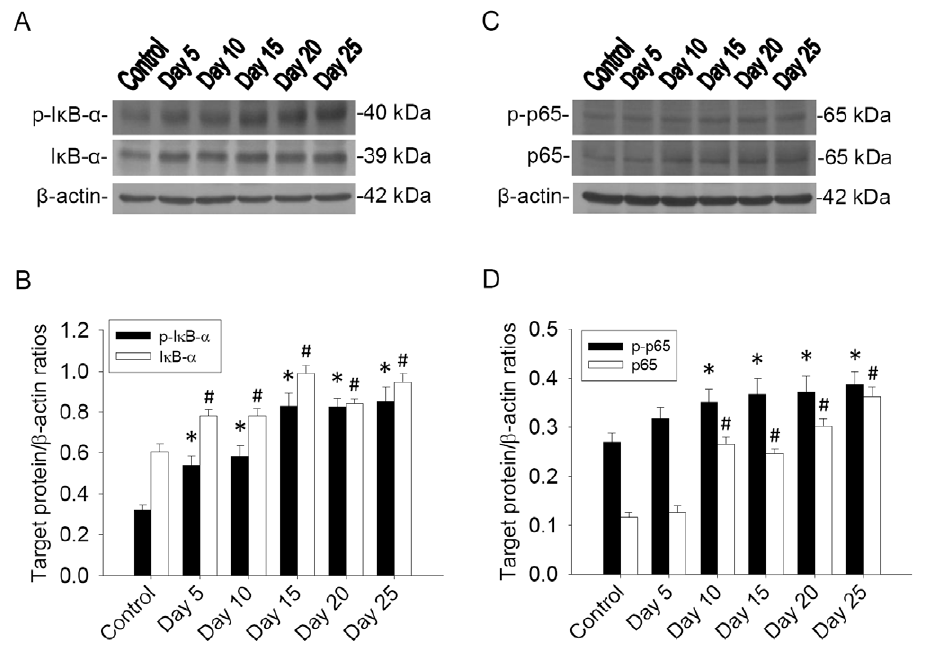
Figure 1. Time-course studies for p-I k B- a and p-NF- k B p65 in mouse brain (A and C). Protein bands of p-I k B- a , I k B- a , p-NF- k B and NF- k B from the brain of mice (n=5) infected with A. cantonensis . b -actin was used as a loading control. (B and D) Quantification and normalization to b -actin showed significant increases not only in p-I k B- a and I k B- a (* P , 0.05) but also in p-NF- k B p65 and NF- k B p65 ( # P , 0.05). Bars represent mean 6 S.D. from three independent experiments performed in duplicate.